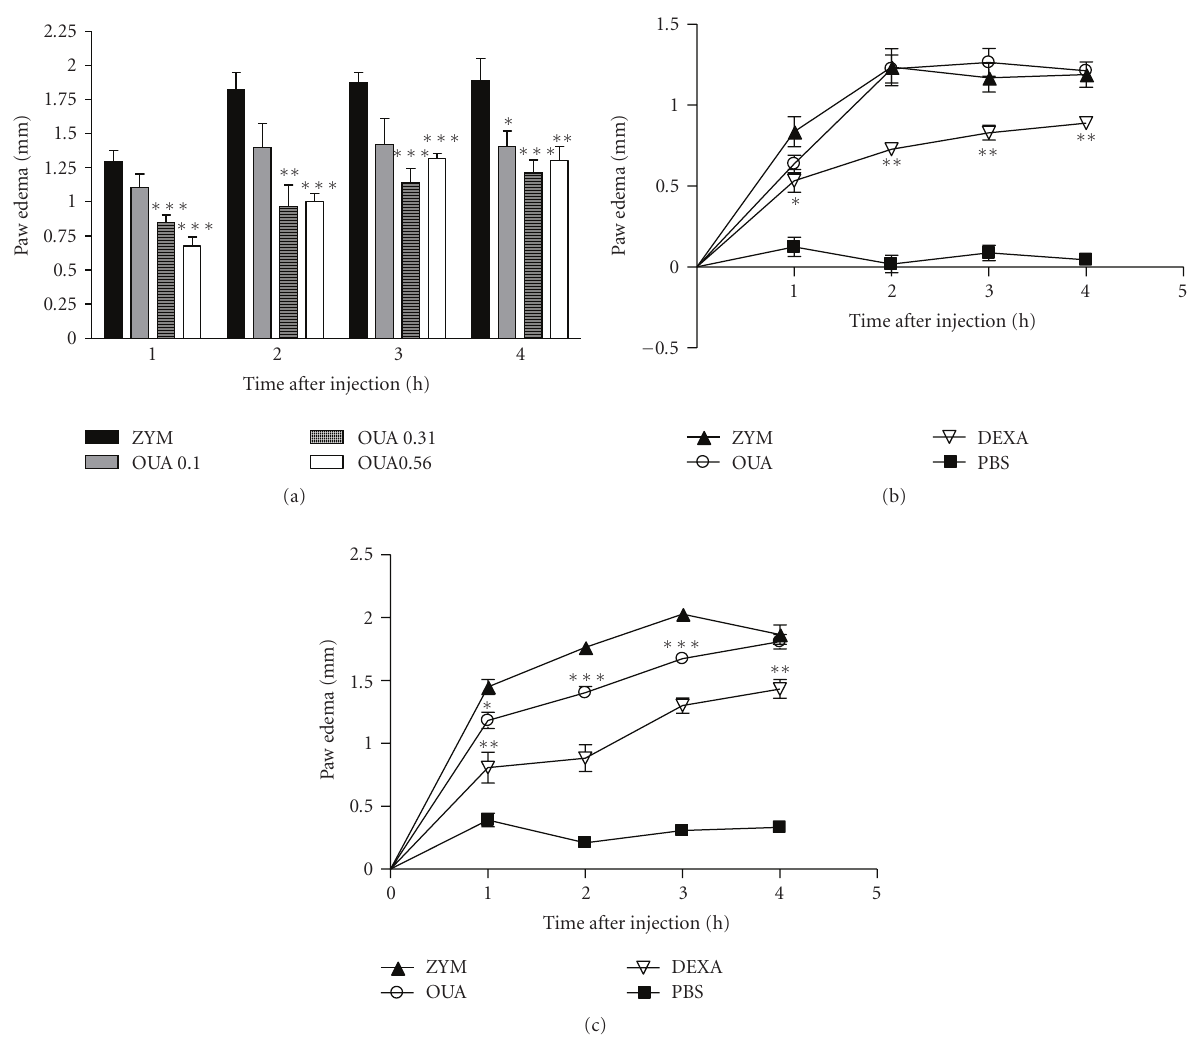
Figure 1: Ouabain dose-response curve and administration for 1 and 2 consecutive days. Mice were pretreated with 0.10mg/kg, 0.31mg/kg and 0.56mg/kg ouabain for 3 consecutive days (a) or with 0.56mg/kg ouabain for 1 (b) and 2 consecutive days (c); one hour after the last ouabain treatment, mice received intraplantar injections of zymosan in 20 μ L phosphate bu ff ered saline (PBS) in the right hindpaw and 20 μ L of PBS in the left hindpaw. Each point represents the mean of eight animals.Dexametasone (DEXA, 0.5mg/kg) was used as antiinflammatory control and injected i.p. one hour before intraplantar challenge. Asterisks denote the significance levels compared with ZYM group. Data were expressed as mean ± S.E.M. and analyzed by software Graphpad Prism using Student’s t -test followed by unpaired test. ∗ P < . 05, ∗∗ P < . 01, and ∗∗∗ P < .